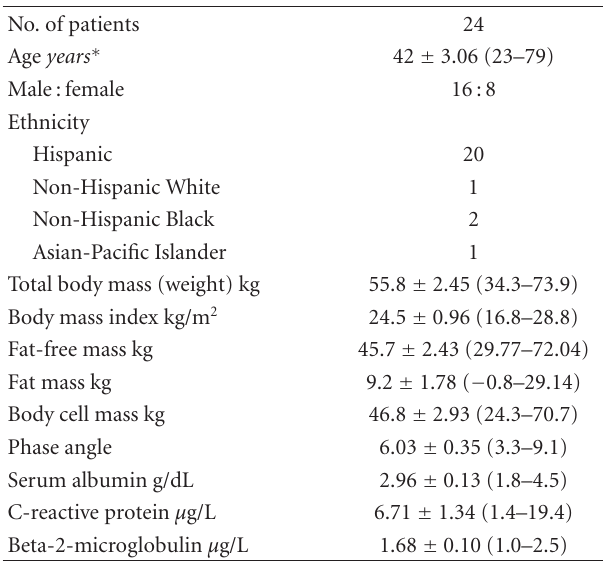
Table 1: Baseline characteristics of study